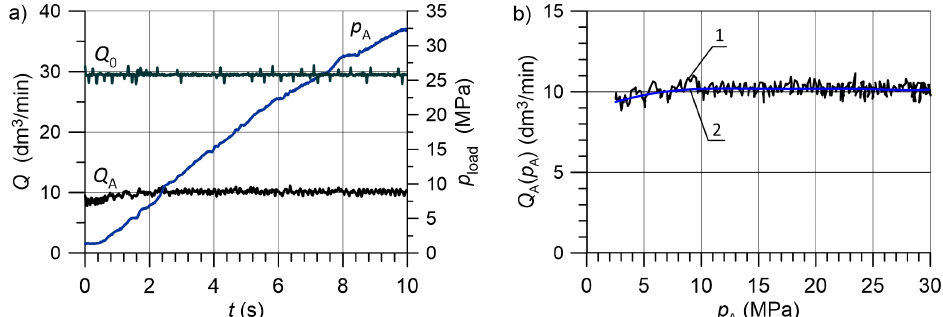
Figure 18. The obtained graphs; ( a ) flow rates and load pressure against time, ( b ) flow characteristics: 1—measured, 2—approximated.